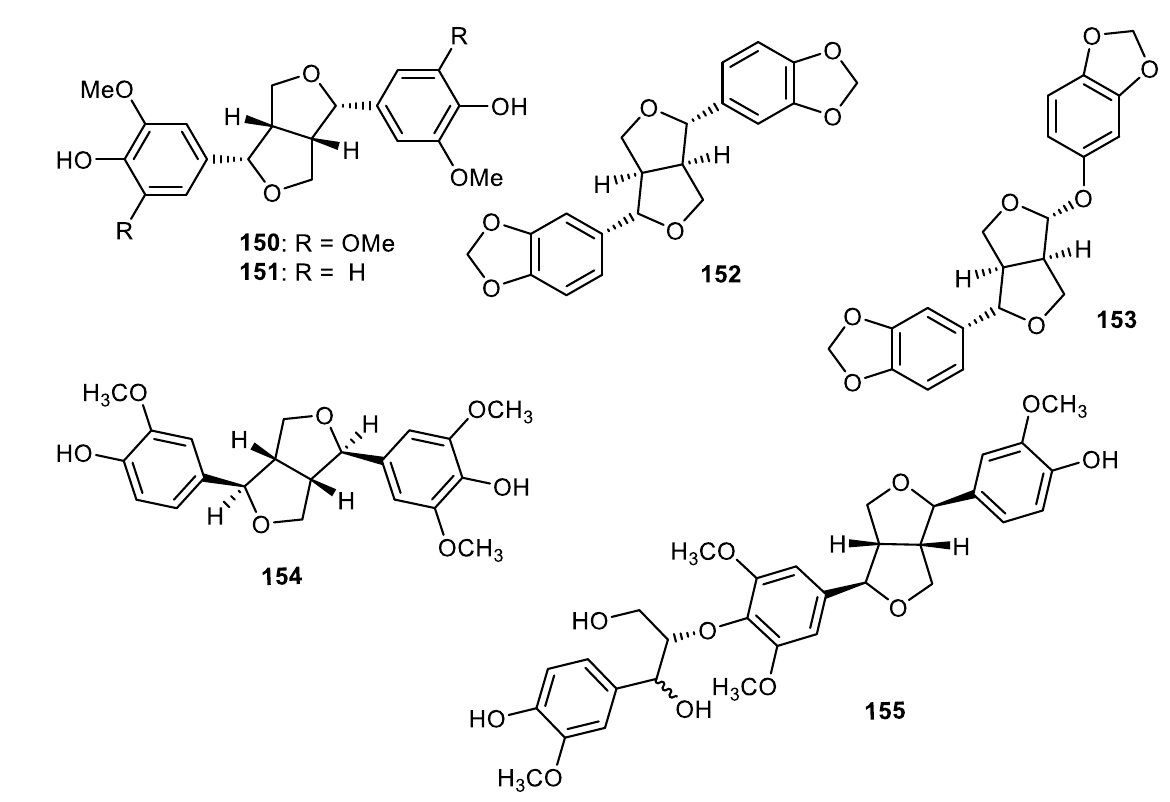
Figure 17. Structures of lignans 150 – 155 .